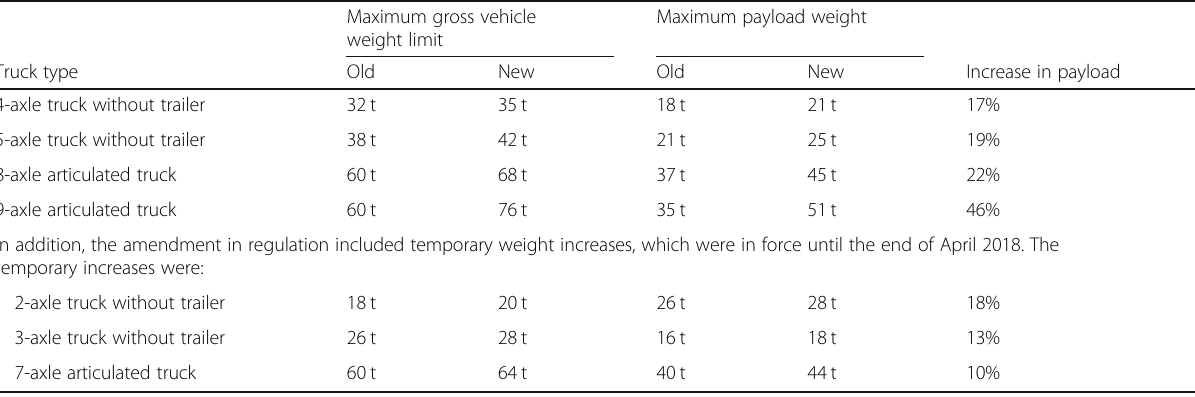
Table 1 Changes in the truck weight limits and